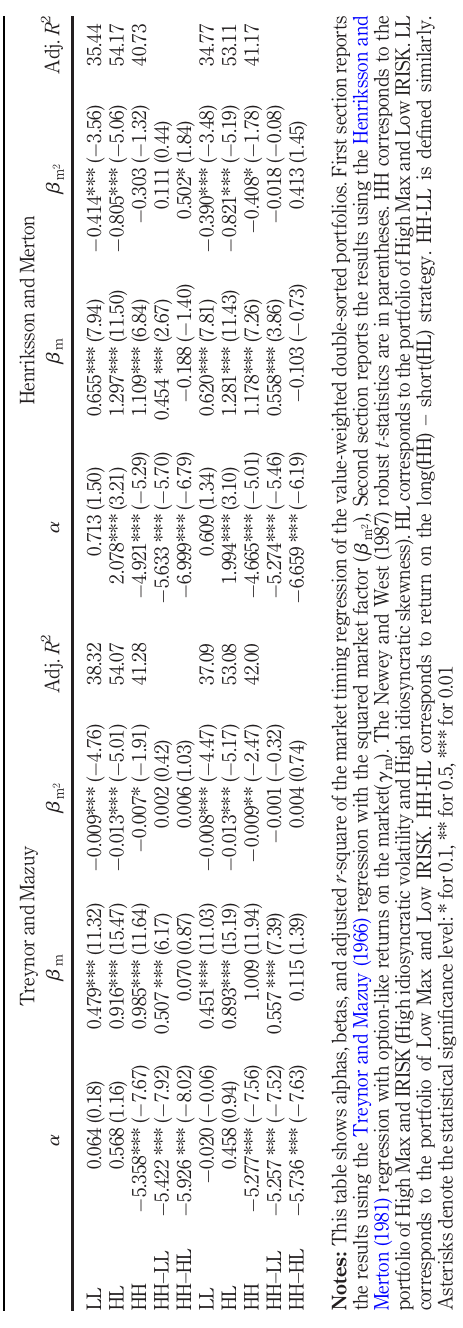
Table 8. Market timing: MAX and